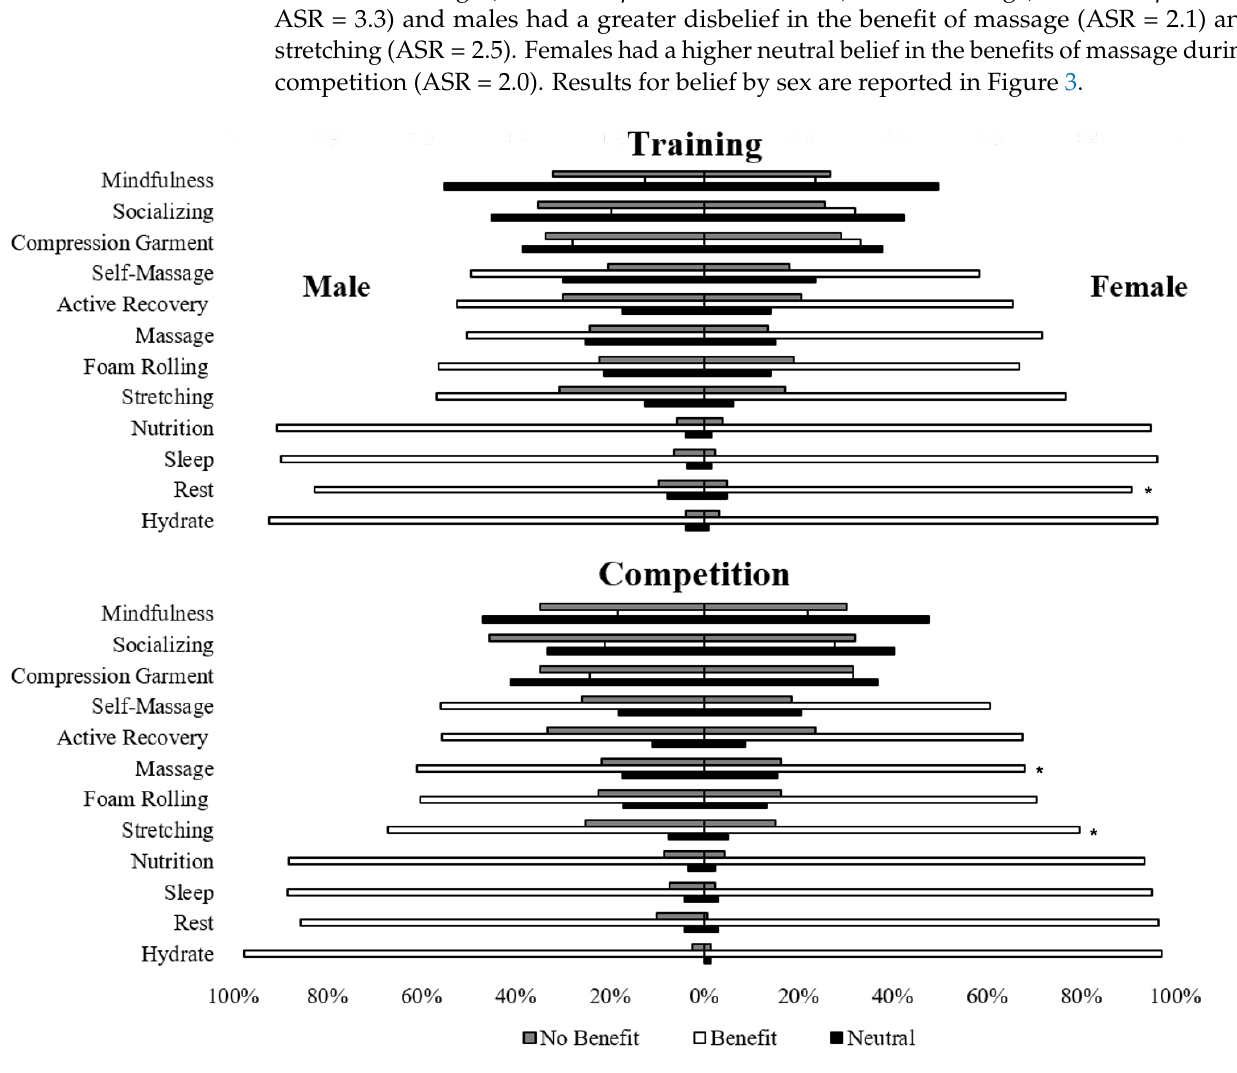
Figure 3. Belief in the recovery strategy in training and competition by sex. Note. * = Females had greater belief in the benefit and males had a greater disbelief in the benefit (α = 0.05). Table 4. Belief by competition outcome.